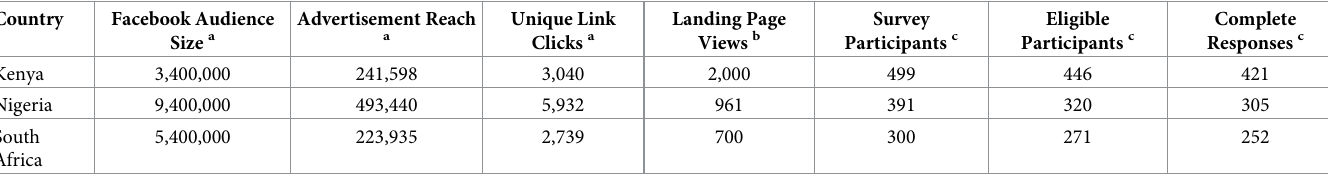
Table 2. Summary of advertisement campaigns and